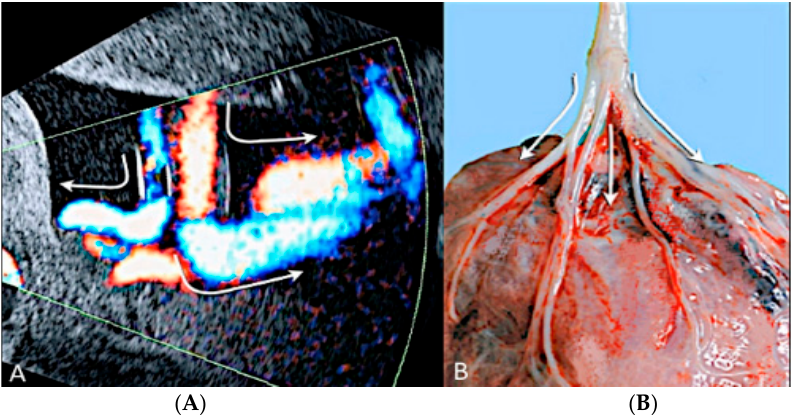
Figure 20. Velamentous cord insertion into the placental membranes ( A ) with direction of blood flow indicated by curved arrows and pathologic correlation (arrows) ( B ) .